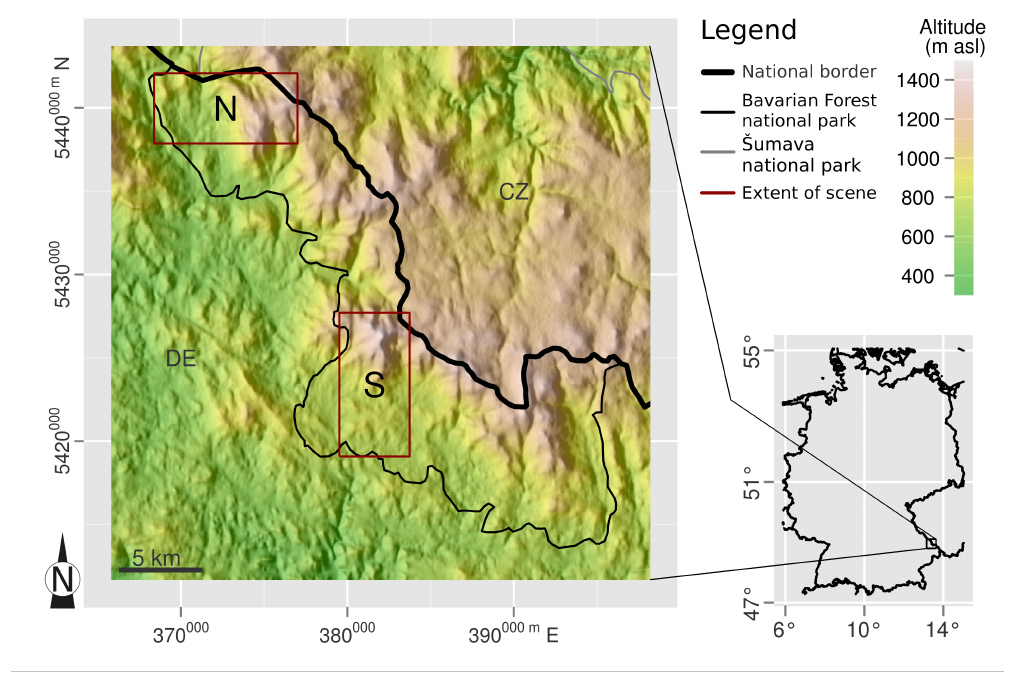
Figure 1. Bavarian Forest national park with bounding boxes of the two hyperspectral scenes. N: northern scene, S: southern scene. Underlying digital elevation model